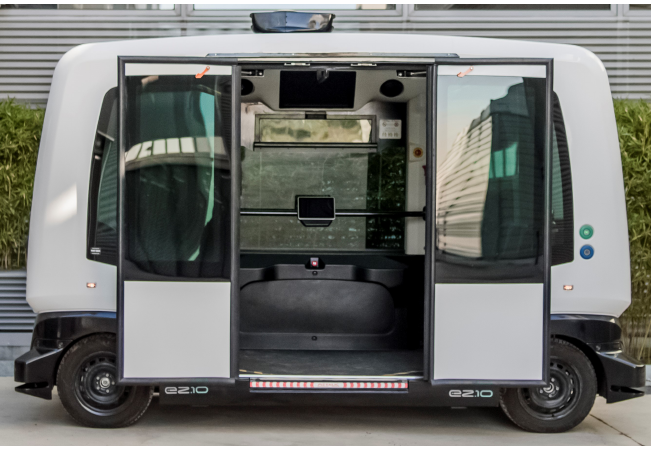
Figure 1. LIGIER